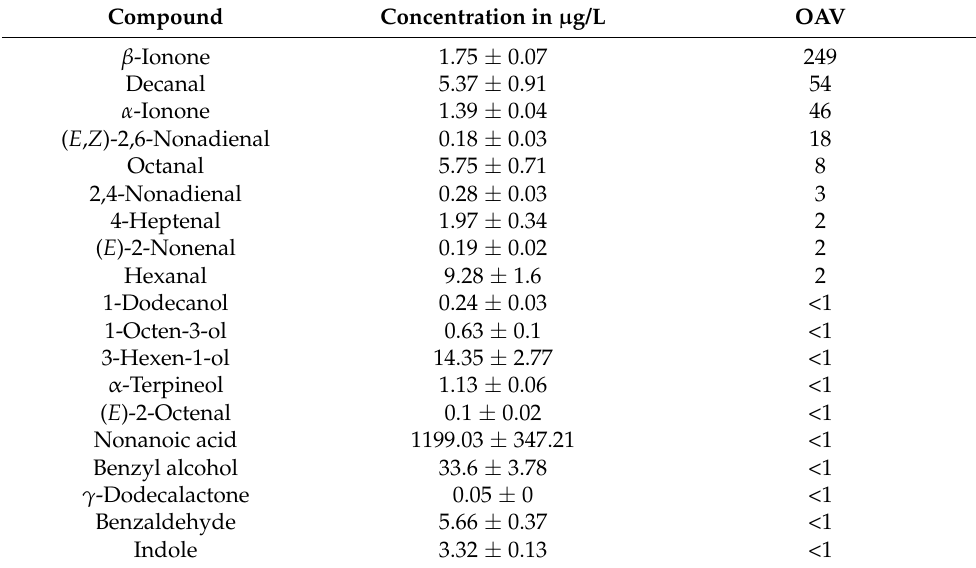
Table A8. Results of semi-quantification and calculated OAVs for sample 234.